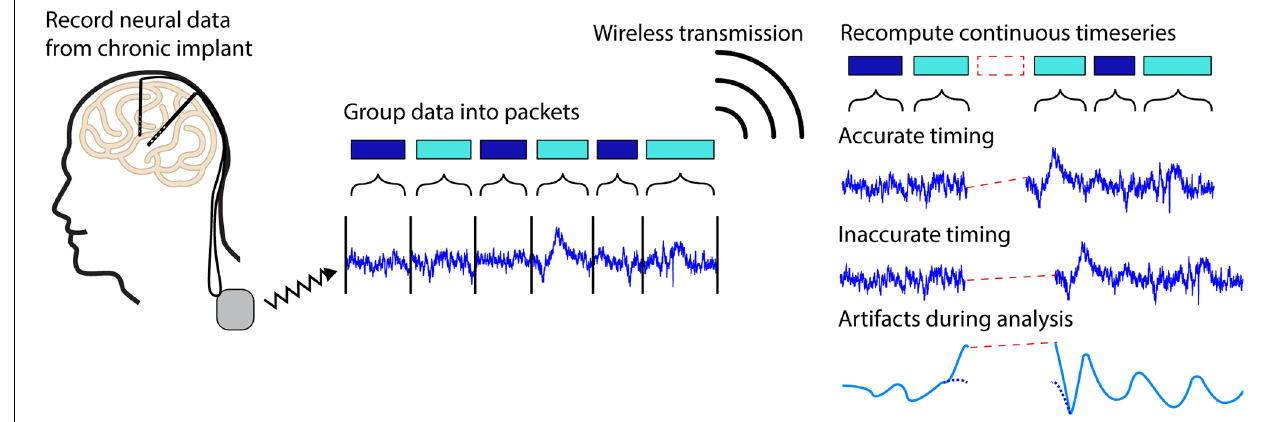
FIGURE 1 | Illustration of packet loss. Neural timeseries data recorded from a chronic implant can be chronically streamed to an external receiver by grouping continuous data into discrete chunks called packets. During transmission, it is possible for packets to fail to reach the receiver leading to regions of missing data known as packet losses. In some systems, it is possible for the timing information contained in each packet to be inaccurate leading to timing offsets in neural signals of interests, artifacts during analyses, and difficulties extracting biologically relevant